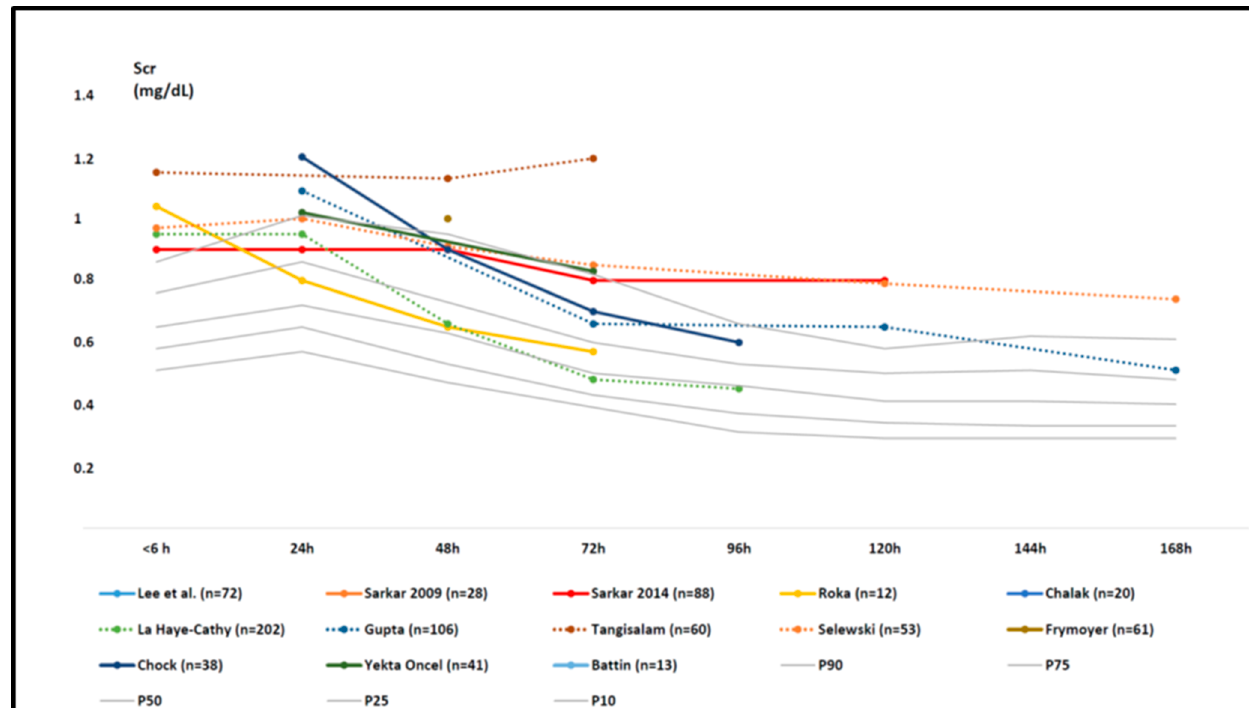
Figure 3. Mean or median serum creatinine (Scr) data as reported in the individual retained studies (colored trends) compared to centile (10th, 25th, 50th, 75th, and 90th centiles) trend values in the reference cohort (Table 1, grey trends) in the first week of postnatal life [27,36–48]. The study size is provided in the legend (number of cases), and additional characteristics can be retrieved in Tables 2 and 3. Aspects related to Scr variability (standard deviation or interquartile range) are provided in Table 4.